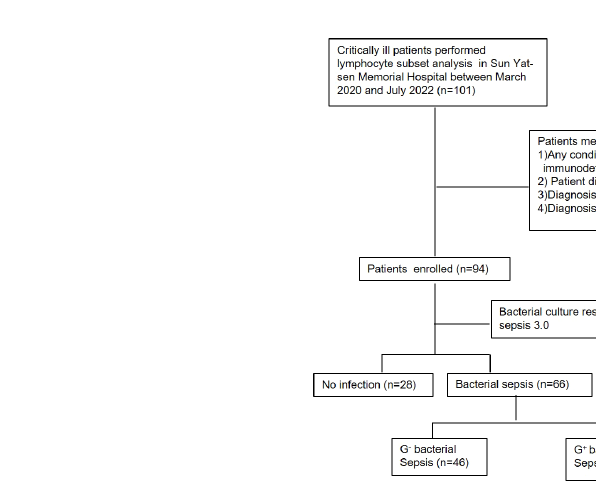
FIGURE 1 Flowchart depicting patients ’